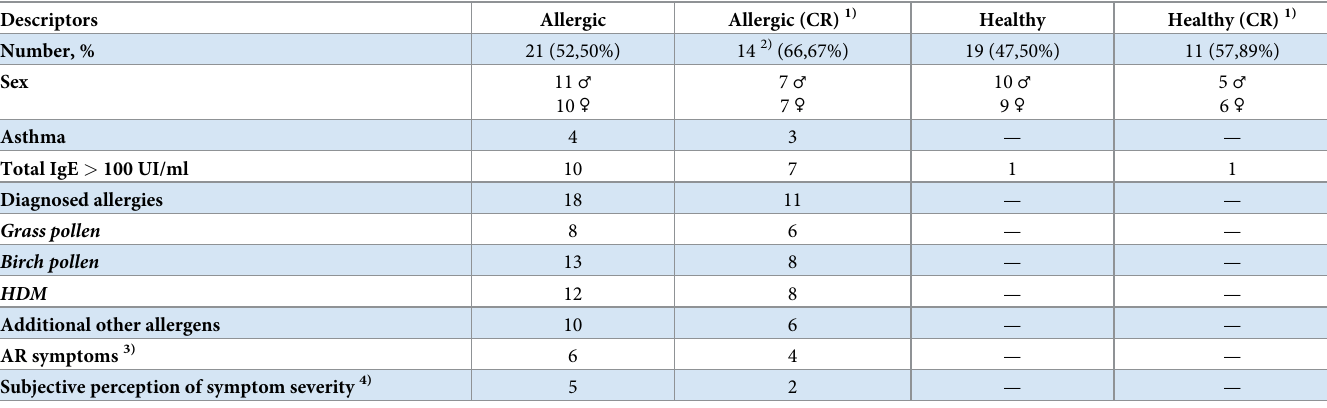
Table 1. Characterization and clinical description of study